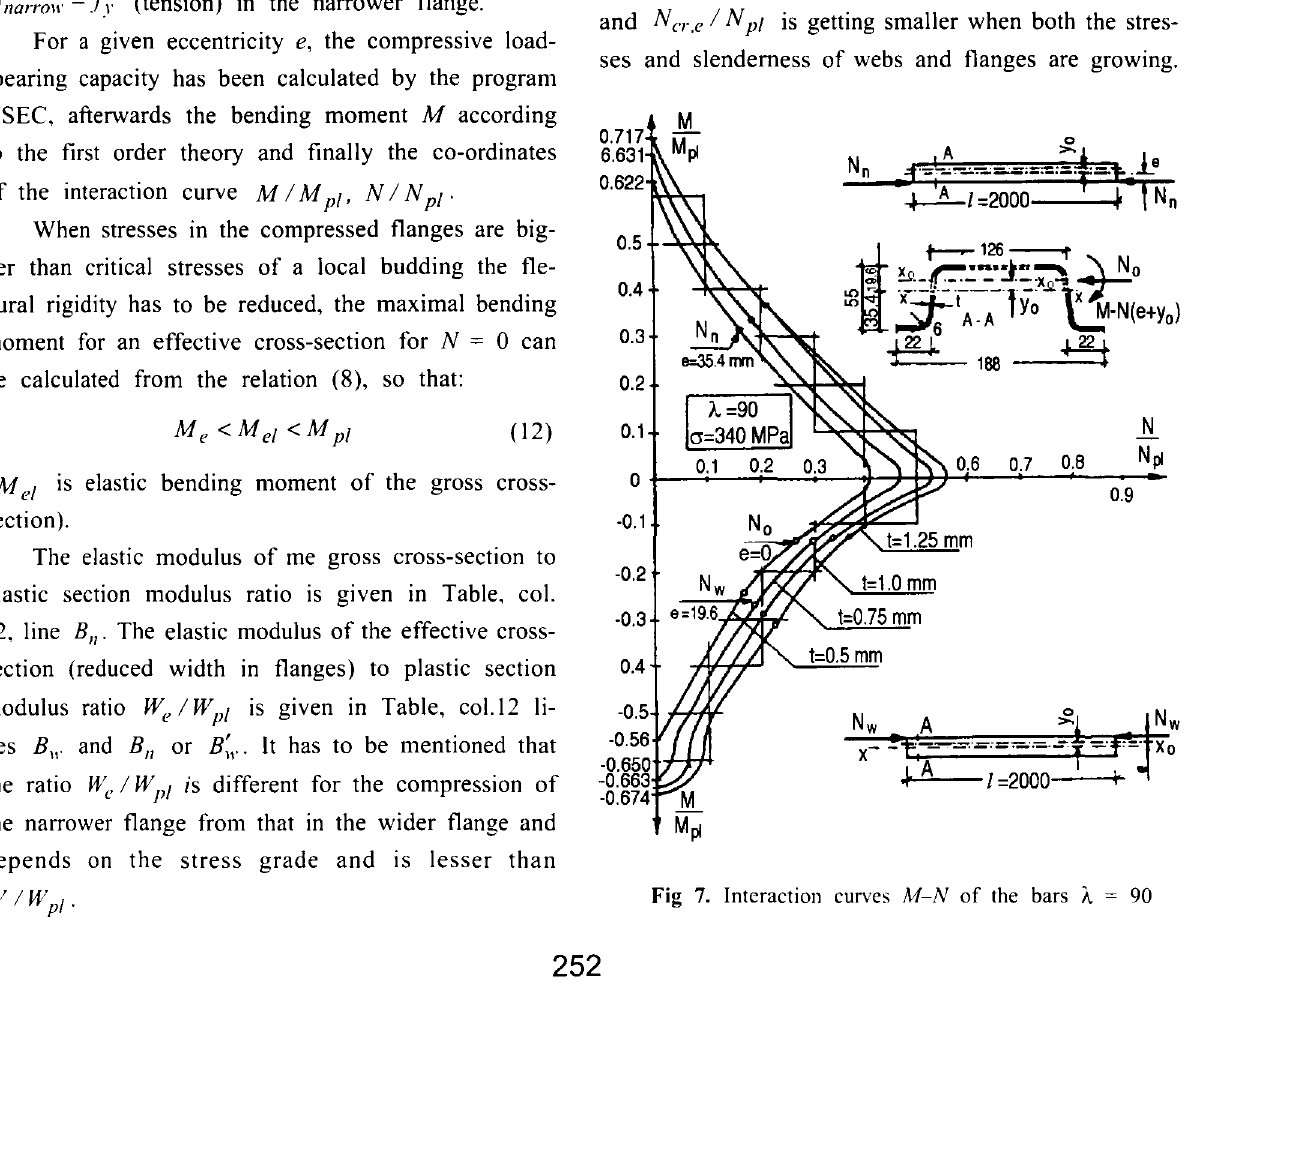
Fig 7. Interaction curves M-N of the bars A = 90